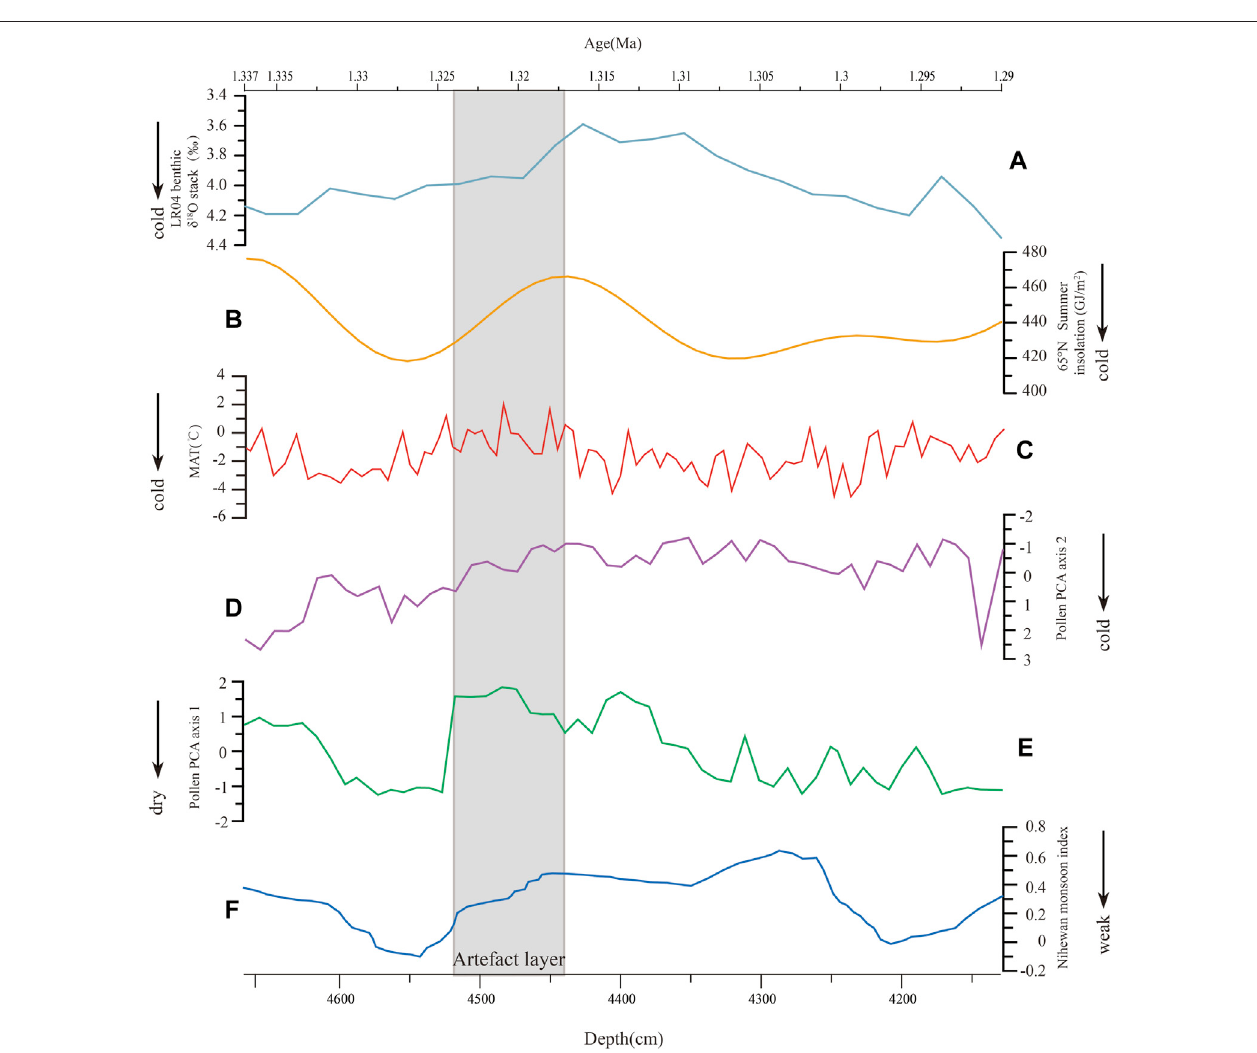
FIGURE7| ComparisonofthepollenPCAaxis1andaxis 2scoresvalueswiththe (A) LR04benthic δ 18 Ostack(LisieckiandRaymo, 2005); (B) summerinsolation at 65 ° N(Berger and Loutre, 1991); (C) mean annual temperature (MAT) reconstruction on the eastern TibetanPlateau (Zhaoet al., 2021); (D) PCA axis 2scoresvalues; (E) PCA axis 1 scores values; (F) Nihewan Basin monsoon index (Ao et al., 2012b).